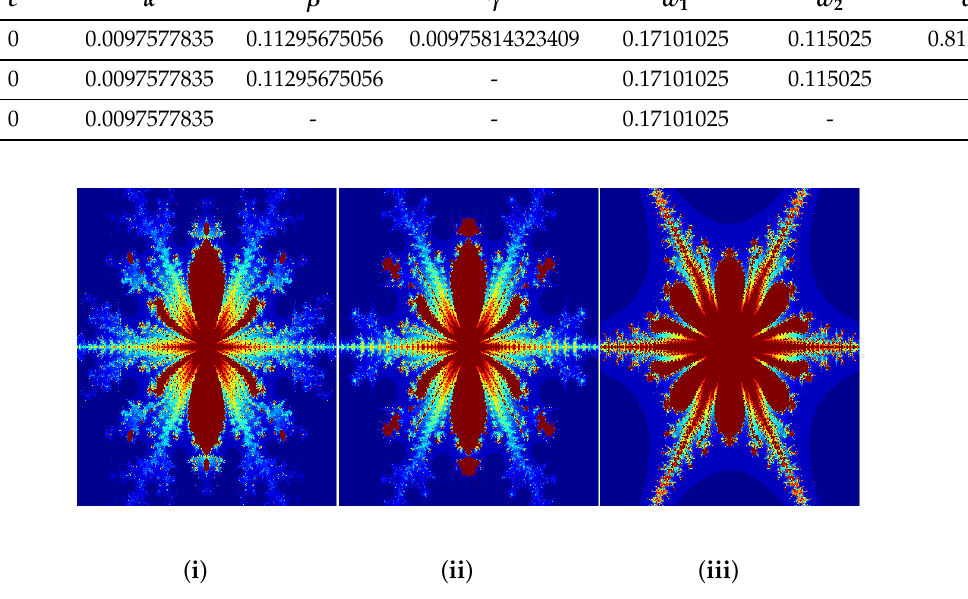
Figure 8. Cubic Julia sets in ( i ) Noor-orbit; ( ii ) Ishikawa-orbit; ( iii ) Mann-orbit.